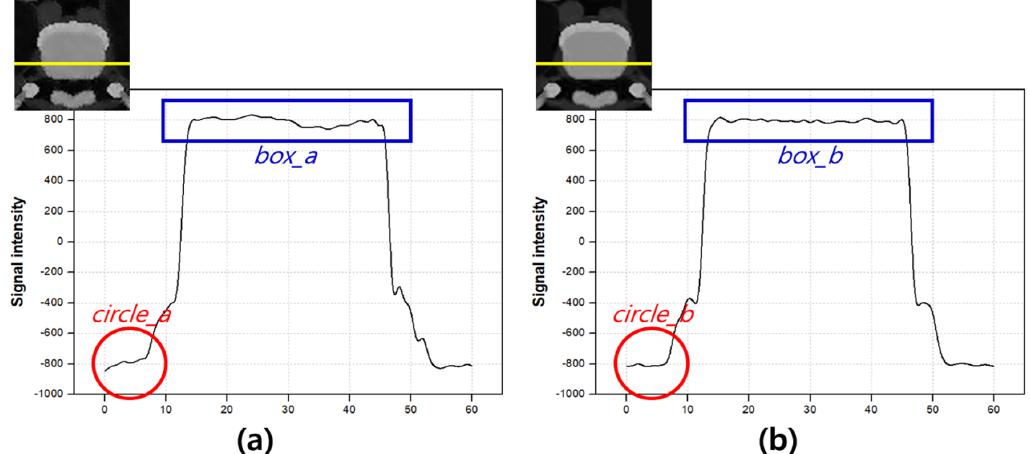
Figure 8. The ( a , b ) are signal intensity profiles of the MASH phantom images applied the Wiener filter and the FNLM denoising algorithm, respectively. The graphs represent the signal intensity of the yellow lines in the images. The boxes represent the denoising performance of the Wiener filter and the FNLM denoising algorithm. The circles represent the sharpness of the